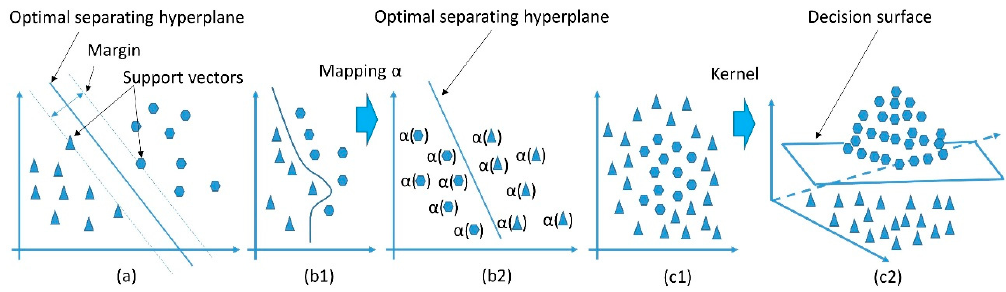
Figure 7. Geometric illustration of support vector machine principle applied to lodging and non-lodging binary classification: ( a ) Linear SVM; ( b1 ) and ( b2 ) Non-linear SVM; ( c1 ) and ( c2 ) Kernel method for non-linear